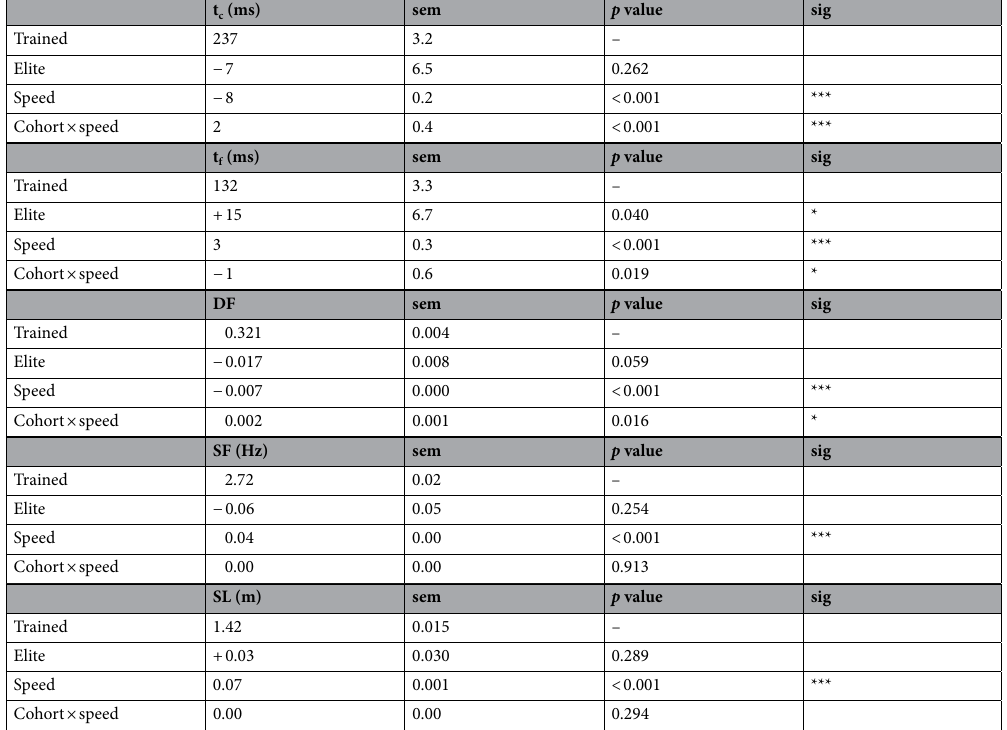
Table 2. Spatiotemporal estimates with effects for cohort, speed, and the interactions. The values provided for the trained cohort correspond to the model estimate at 14 km/h, with the elite difference, speed-relation (all subject change per km/h), and cohort-speed interaction presented below that. Estimated standard errors are provided for each effect 68 . Statistical significance of each effect is indicated as: * p < 0.05 and *** p <